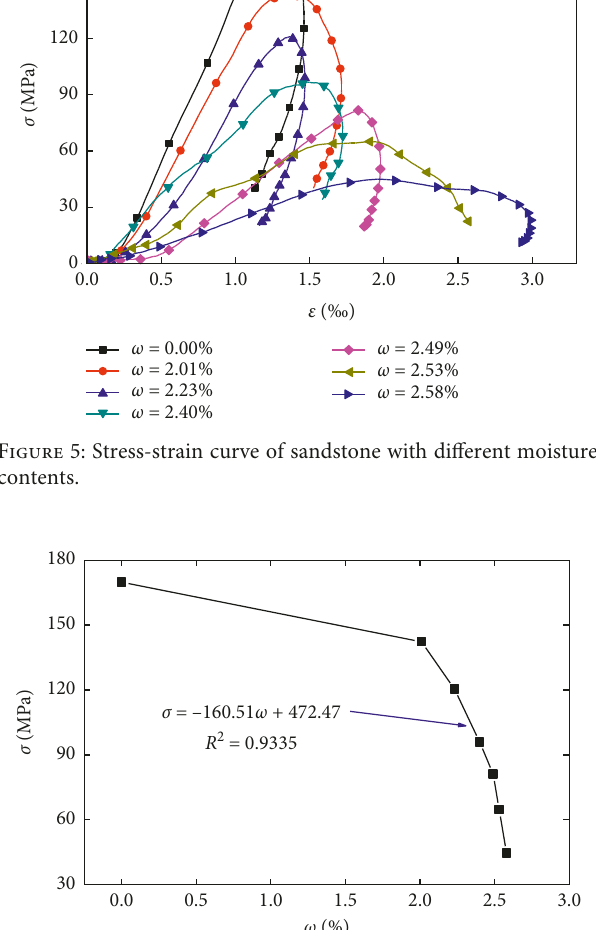
Figure 6: Variation curve of peak stress with moisture